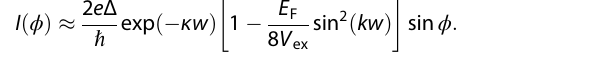
ffiffiffiffiffiffiffiffiffiffiffiffiffiffiffiffiffiffiffiffiffiffiffiffiffiffiffiffiffiffiffiffi p ffiffiffiffiffiffiffiffiffiffiffiffiffiffiffiffiffiffiffiffiffiffiffiffiffiffiffiffiffiffiffiffi 2 m (cid:6) ð V ex (cid:3) E F Þ